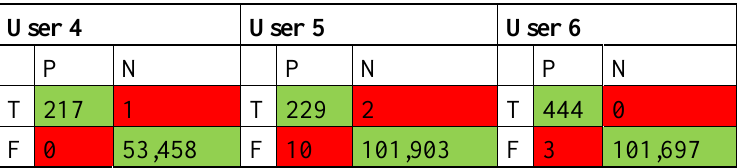
Table 3. Confusion matrix for the R wave II.